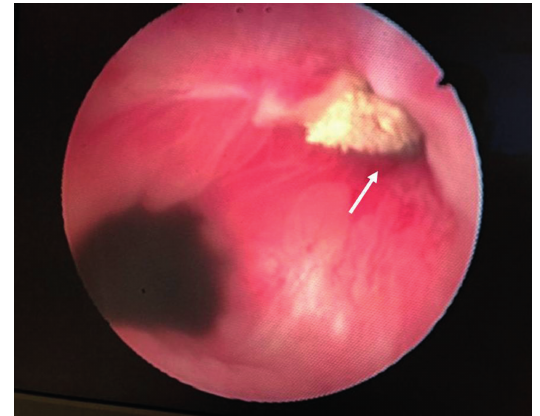
Figure 2 - Endoscopic view showing an orifice of the fistula (white arrow) located in the anterolateral region of the prostatic